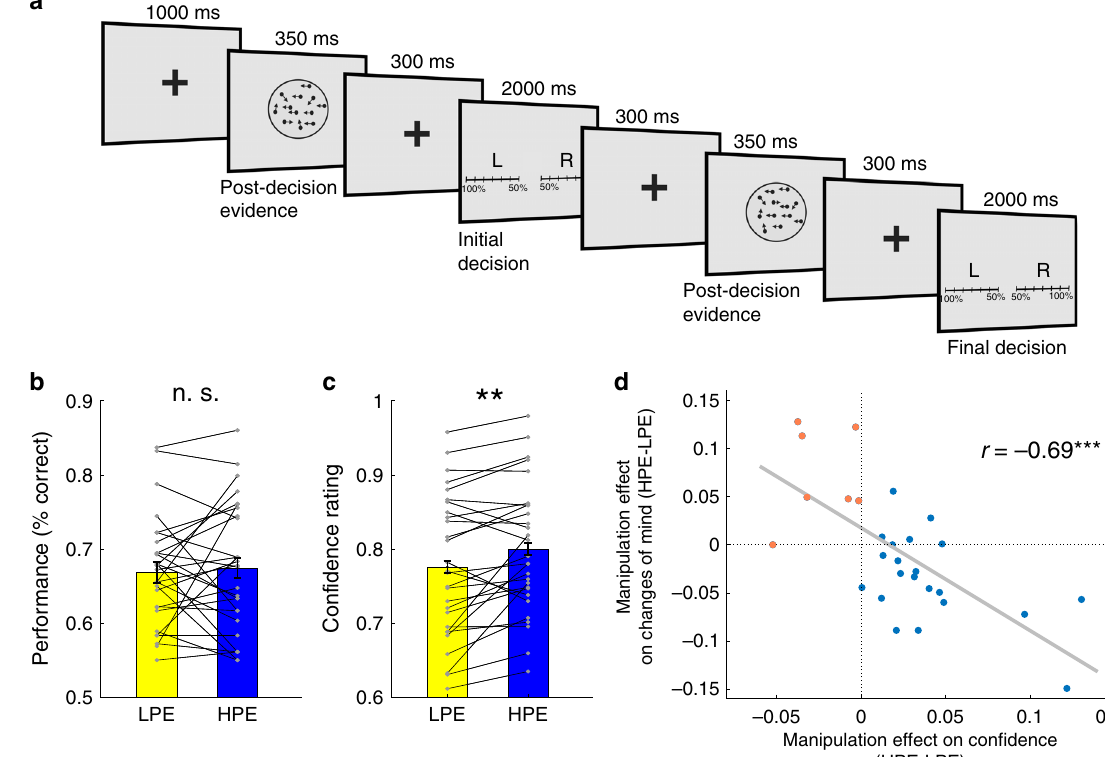
Fig. 1 Task design and results of behavioural study 1 ( n = 28 participants). a Trial timeline. Note that participants fi rst had to indicate a binary left versus right decision (i.e. a two alternative forced-choice), and then indicate their con fi dence in this decision by moving a cursor along the selected scale. b , c A psychophysical manipulation of positive evidence selectively increased con fi dence of the fi rst decision ( c ) while keeping accuracy constant ( b ). This increase in con fi dence was replicated across all three studies. Data are presented as mean values ± SEM; grey dots represent individual participant data. Paired t -test (two-tailed): ** p = .005. LPE = low positive evidence condition; HPE = high positive evidence condition. d Between-subject relationship between the degree to which positive evidence increased con fi dence ( x -axis: con fi dence in the high positive evidence condition — con fi dence in the low positive evidence condition) and its effect on changes of mind ( y -axis: changes of mind in the high positive evidence condition — changes of mind in the low positive evidence condition). This correlation was replicated in all three studies. Orange data points represent subjects showing the opposite of the intended effect of the manipulation on con fi dence (higher con fi dence in the low positive evidence condition). Pearson correlation (two-tailed): *** p <